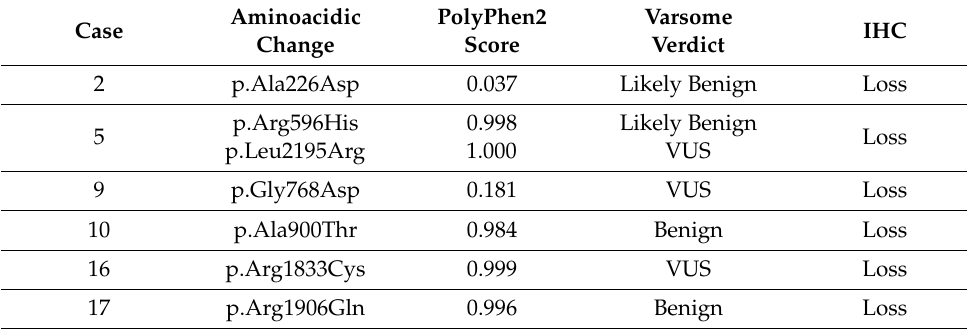
Table 4. Cases with loss IHC staining and missense ARID1A mutation. Aminoacidic Case Change